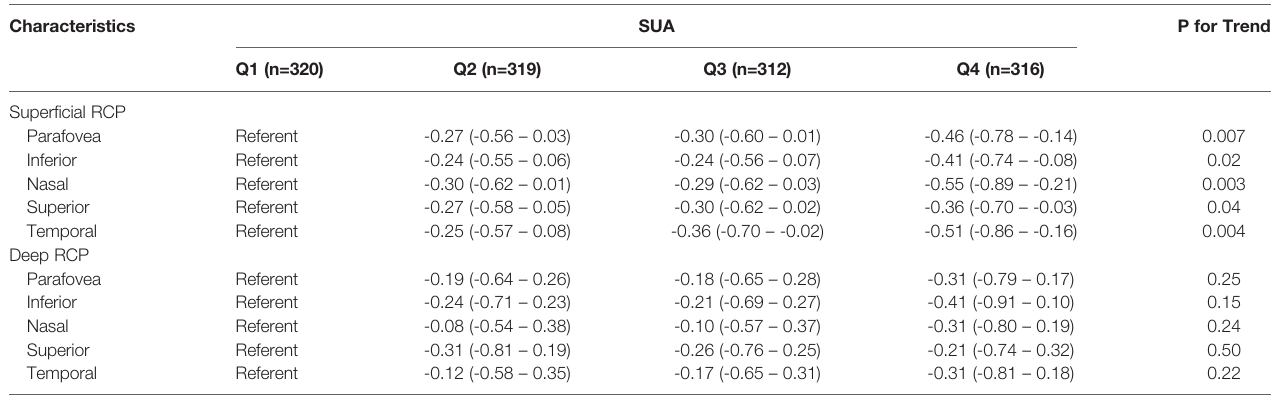
TABLE 3 | Association between serum uric acid and retinal capillary plexus in men. Characteristics